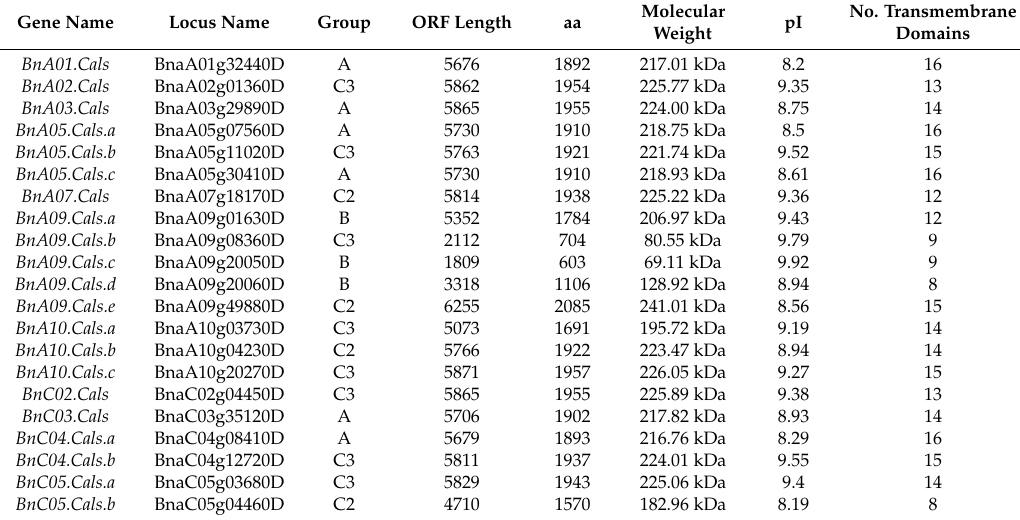
BnA10.Cals.a BnaA10g03730D C3